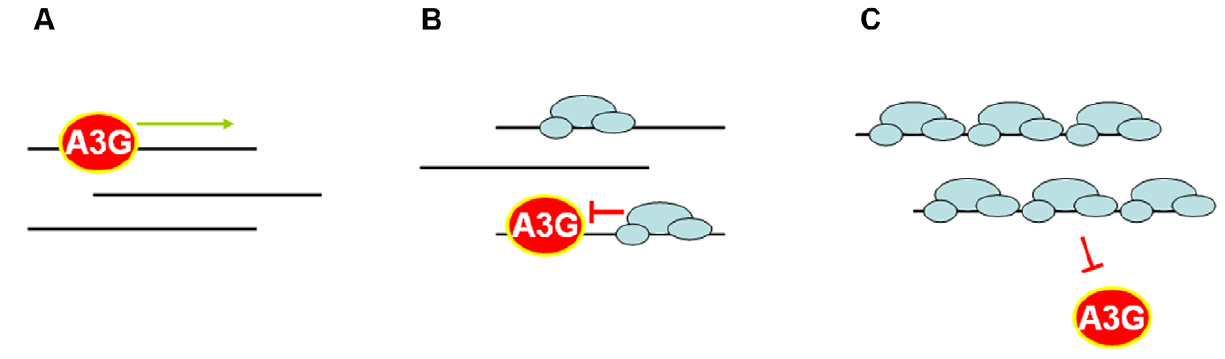
Figure 9. Model of the inhibitory effect of RPA on the deaminase activity of A3G. (a) In the absence of RPA, for example in the cytoplasm, A3G is able to access ssDNA and slide along it (green arrow), catalyzing multiple deaminations. (b) In the presence of intermediate RPA concentrations, only a fraction of ssDNA that is not covered by the RPA is accessible to the deaminase. A3G binds to the available ssDNA regions, but further sliding and/or jumping is hampered by the RPA bound to ssDNA. Processivity of the enzyme is inhibited much stronger than the deamination activity, and the degree of processivity inhibition depends on the extent of coverage of ssDNA by RPA. This scenario likely reflects the situation in the nuclear loci such as the yeast URA3 gene. (c) High concentrations of RPA completely prevent access of A3G to the ssDNA. It results in 100% inhibition of deamination activity.